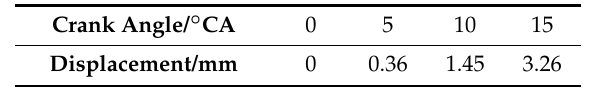
Table 2. Piston displacement at different crank angles.